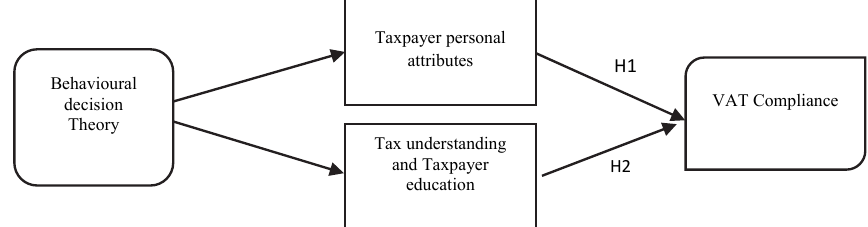
Fig. 2. Relationship between Taxpayer’s Attributes, Tax Education and VAT Compliance Under Behavioral Decision The-